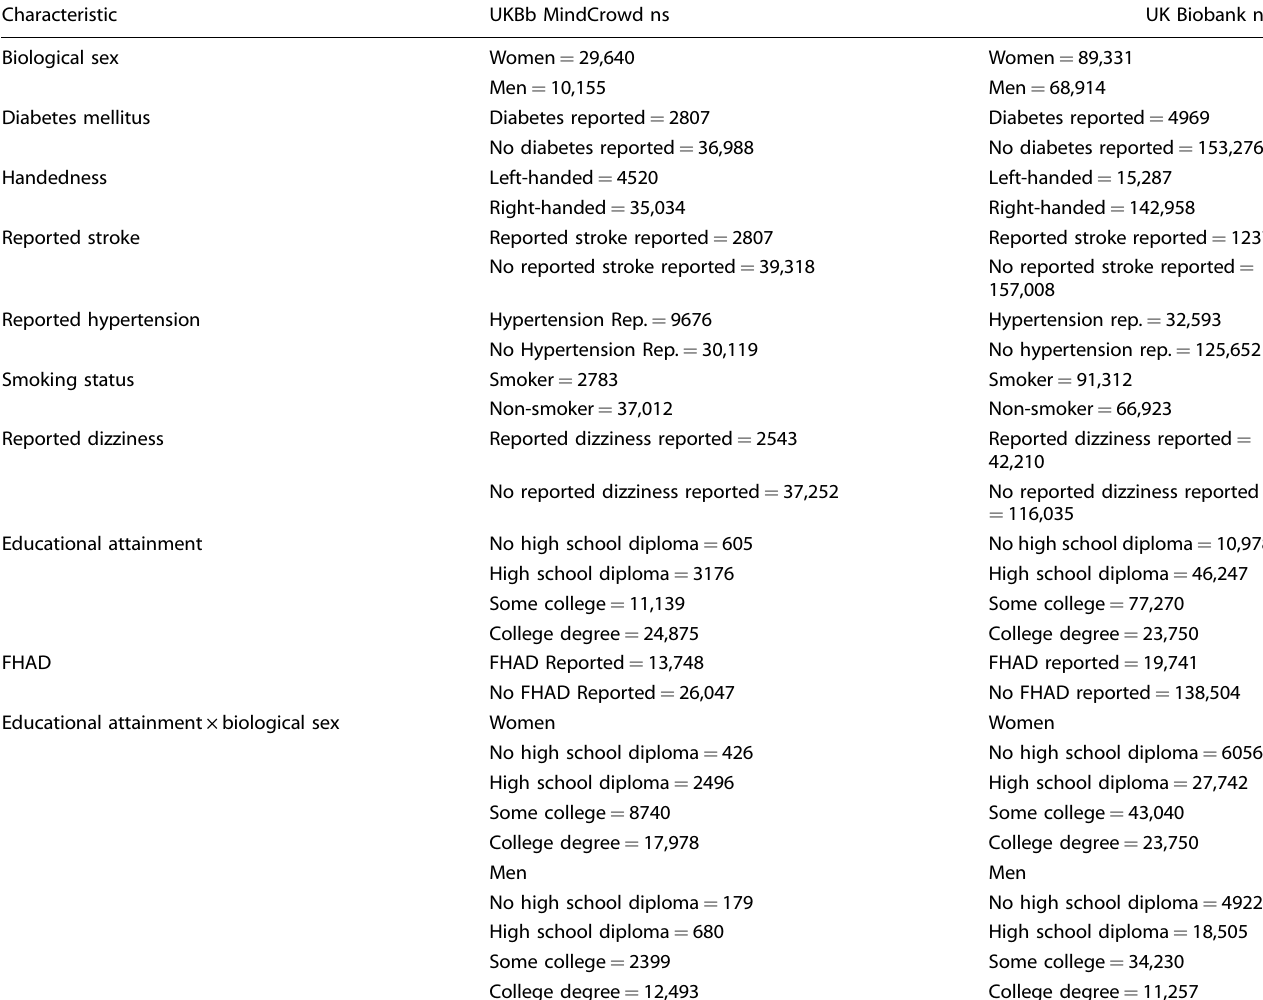
Table 4. UKBb MindCrowd and UK Biobank ’ s sample size (ns)